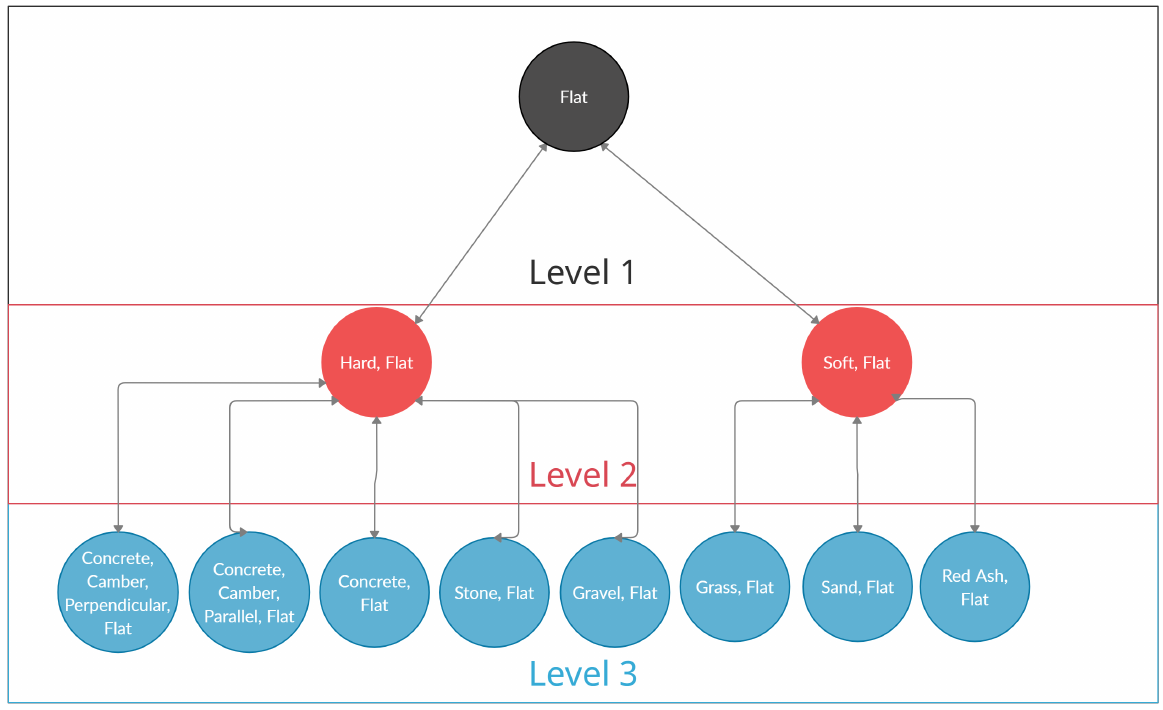
Figure 4. Example of the label consolidation process for “flat” activity